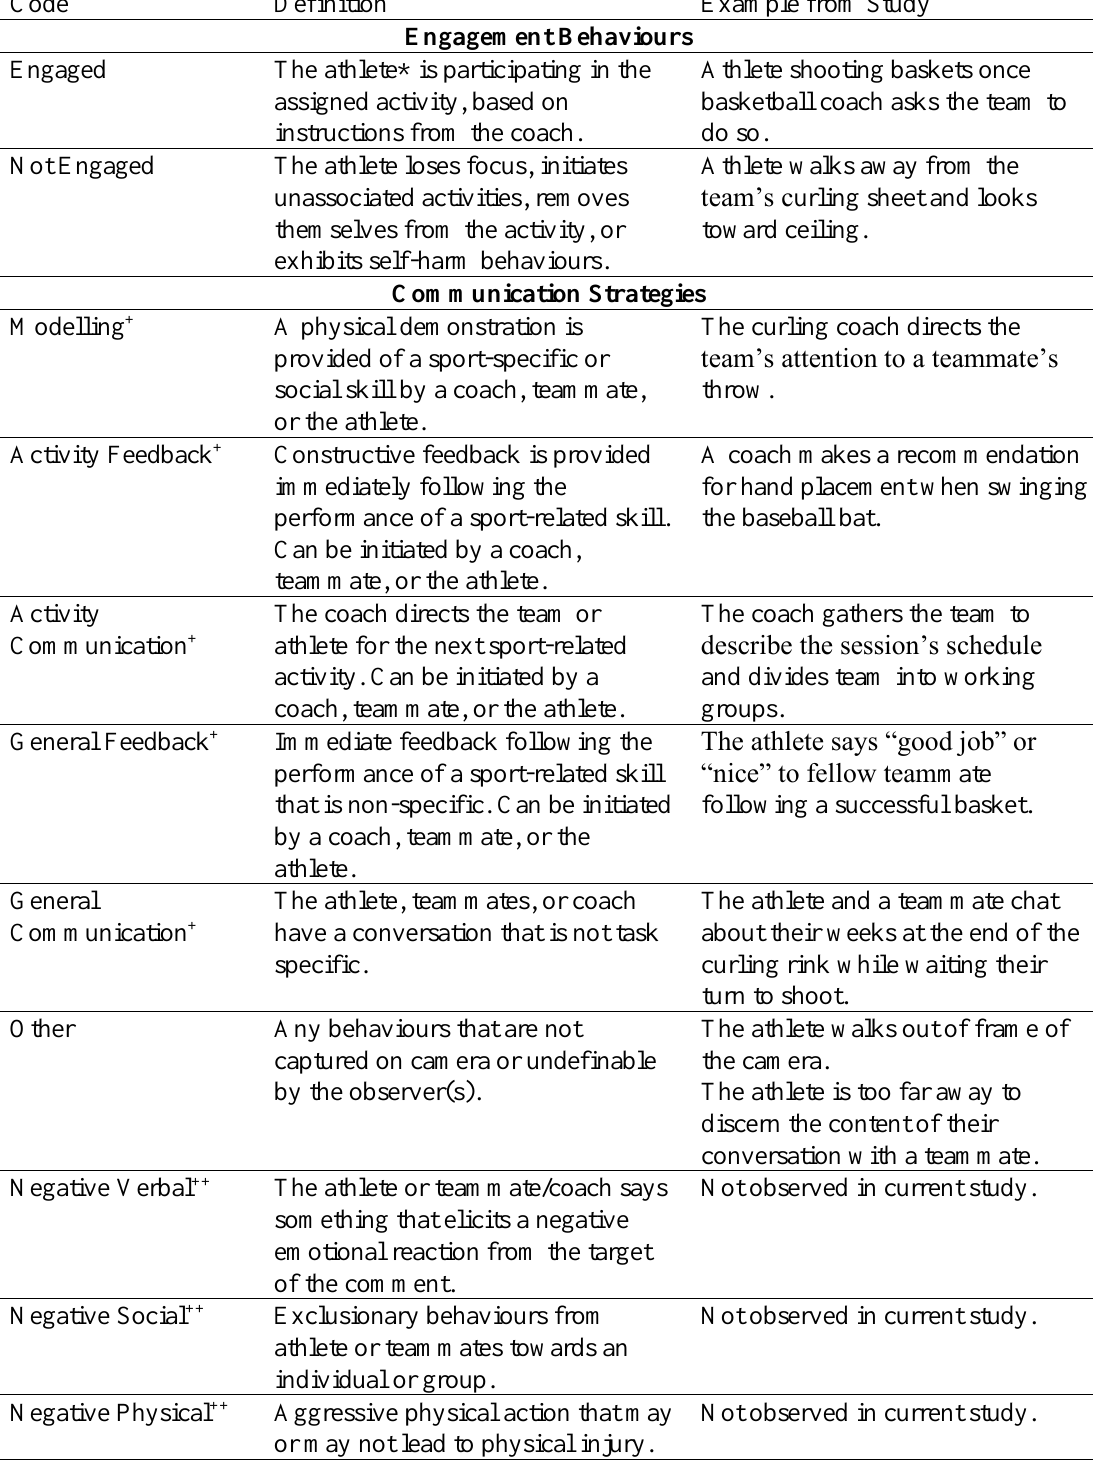
Table 1. A summary of the modified observational coding